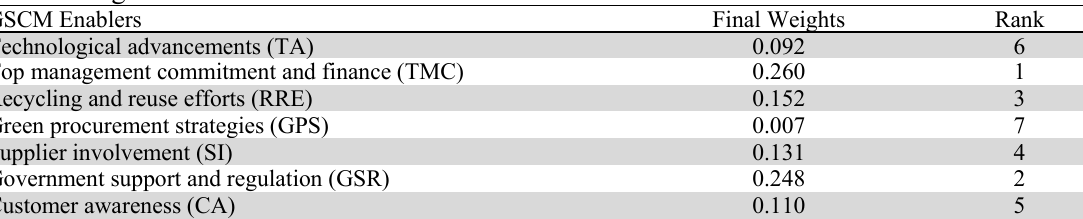
Final ranking of GSCM enablers GSCM Enablers Final Weights Rank Technological advancements (TA) Top management commitment and finance (TMC) 0.260 Recycling and reuse efforts